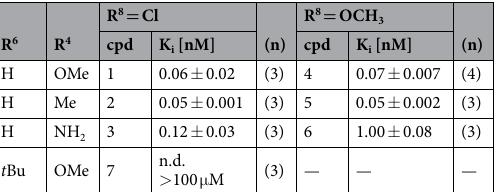
Table 2. K i values of compounds 1 – 7 determined by displacement of [ 3 H]flunitrazepam binding to rat cerebellar membranes (mean ± SEM, n =